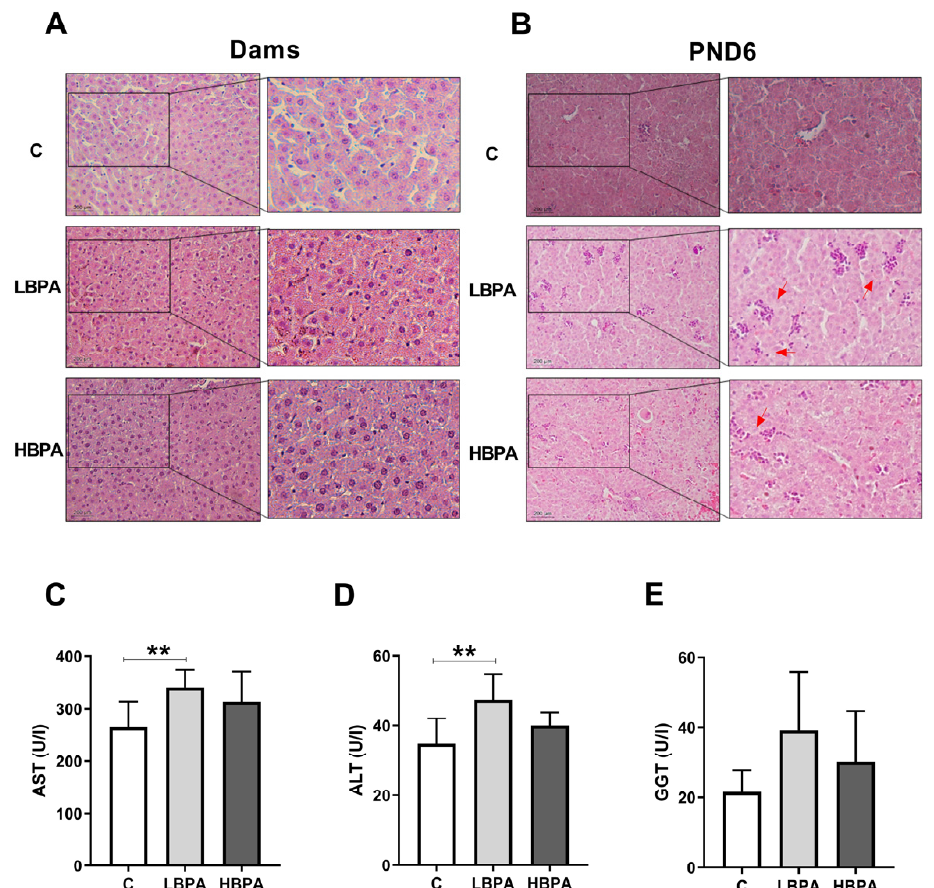
Figure 10. Histology and clinical chemistry of liver functional markers after BPA administration. Representative images of livers from dams ( A ) and female PND6 offspring ( B ) stained with H&E in control and low and high BPA treatment groups (LBPA or HBPA). Scale bars indicate 200 µ m (20 × ) and magnified image of the characteristic tissue section (40 × ). Red arrows indicate the aggregation of nuclei. ( C ) Aspartate aminotransferase (AST); ( D ) alanine aminotransferase (ALP) and ( E ) gamma glutamyl transpeptidase (GGT) in U/L in serum dams. Data represent mean ± SD. n = 8 control dams; n = 8 LBPA dams; n = 6 HBPA dams. Statistical significance was determined by one-way ANOVA. ** p < 0.01.